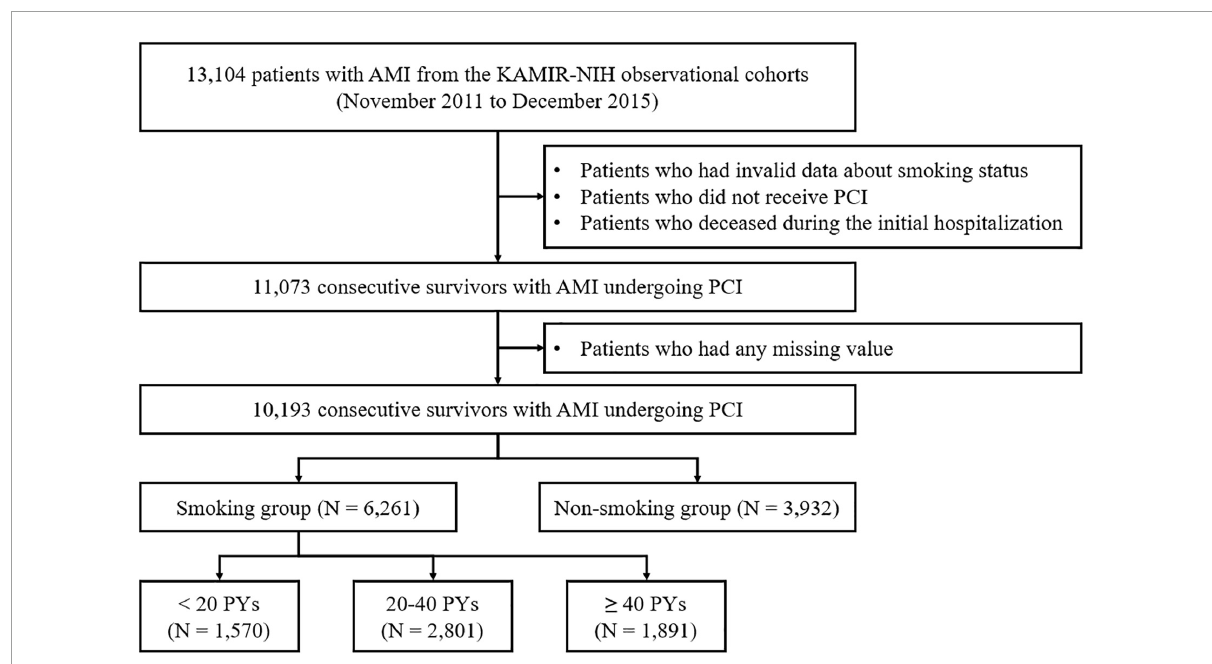
FIGURE1 Flow chart of the study participants. AMI, acute myocardial infarction; KAMIR-NIH, Korea acute myocardial infarction Registry-National Institutes of Health; PCI, percutaneous coronary intervention; PY, pack